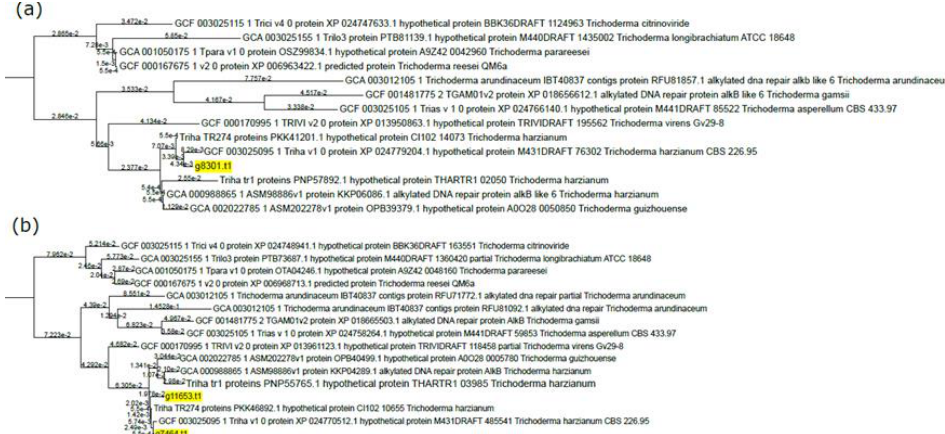
Figure 2. DNA alkylation damage-related genes in T. lixii MUT3171 and their relationship with other Trichoderma species: Distance tree of orthologous Trichoderma enzymes with a putative function in DNA protection against alkylation damages; distances are provided in scientific notation. The distance trees were generated through the OrthoFinder 2.0 pipeline. Trichoderma lixii MUT3171 sequences are highlighted in yellow. ( a ) g8301.t1 showed a very low level of divergence compared with its closest ortholog found in T. harzianum TR1, ( b ) g11653.t1 revealed a higher level of divergence compared with putative orthologs and the paralog g7464.t1.